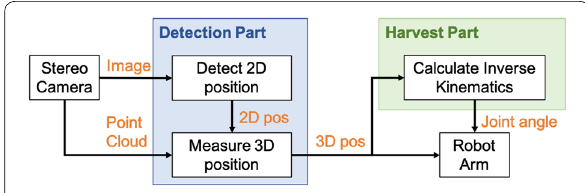
Fig. 2 Flow chart for harvest of